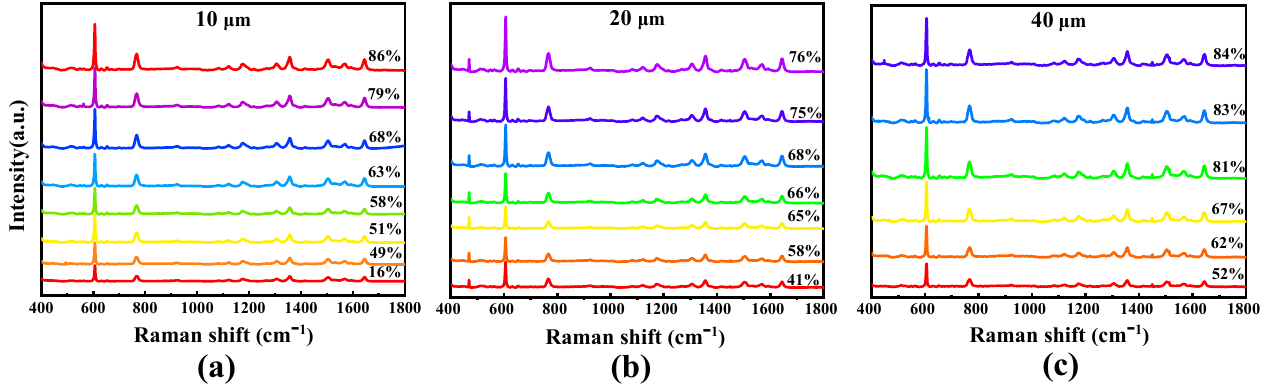
Figure 8. R6G Raman spectra of substrate A with different duty cycles: ( a – c ) 10, 20 and 40 μ m spot sizes.